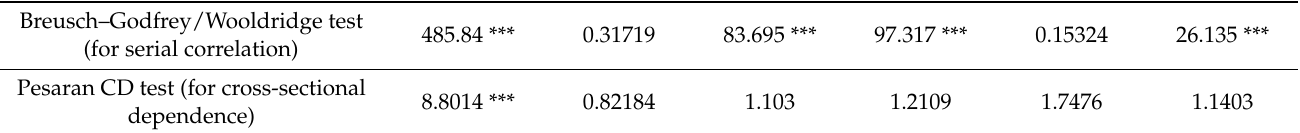
Table 5. Robustness checks for the one-way country panel models with fixed effects estimator and standard errors.